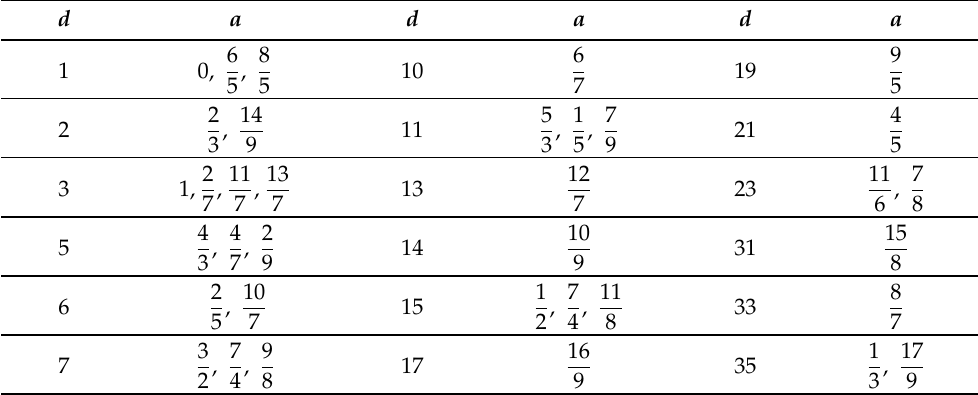
Table 1. The first positive square-free integers d , and corresponding fractions a with denominators √ − d ) up to 9 which generate the field Q (